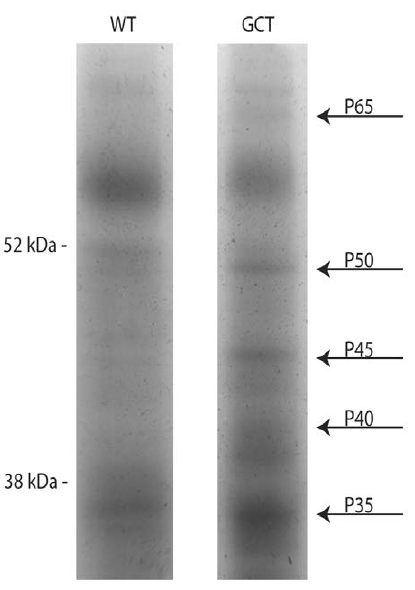
Figure 1. Differential protein expression in mouse granulosa cell and GCT cell culture media. Samples were separated by 10% SDS-PAGE followed by silver staining. Arrows indicate examples of proteins expressed selectively in the GCT cell culture media, along with approximate molecular weights. A total of 3 gels with different acrylamide contents were studied and 14 bands (with proteins from 12 to 116 KDa) were subjected to mass spectrometry analysis. Only one of the 3 gels is shown on the figure.